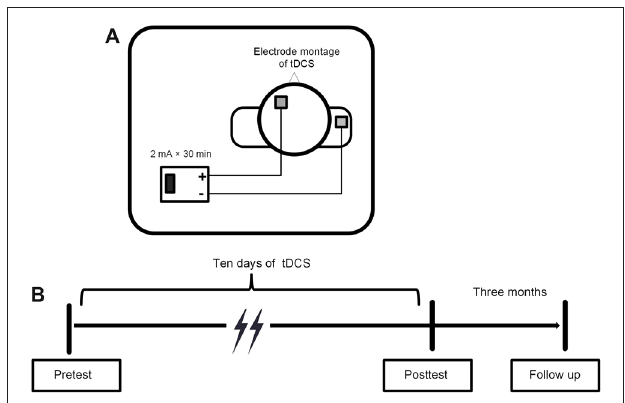
FIGURE 3 | (A) Electrode montage of tDCS. (B) Experimental procedure of